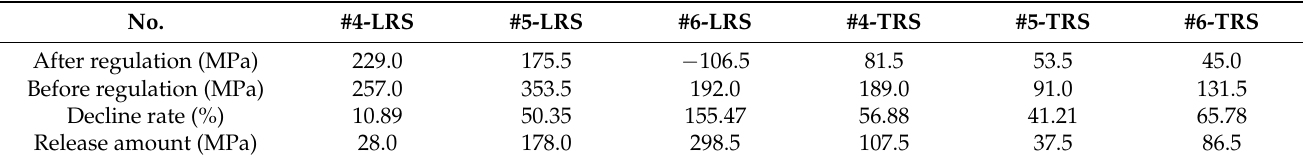
Table 9. Peak residual stress changes on the reverse side of samples #4, #5, and #6.